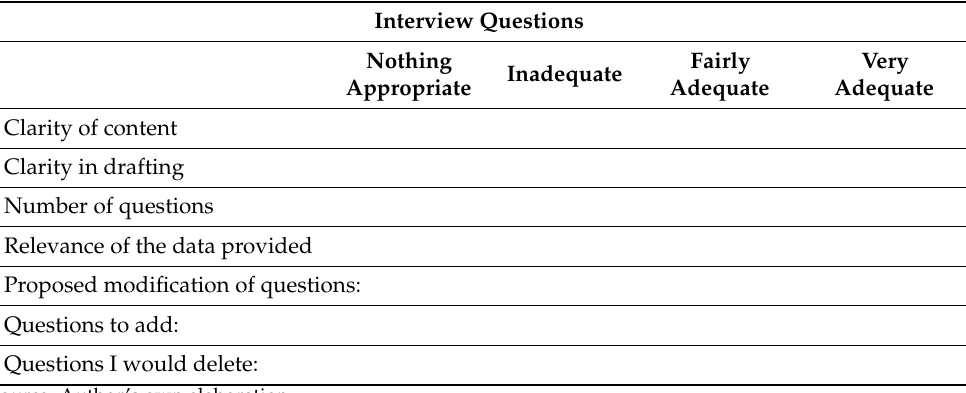
Table 3. Validation